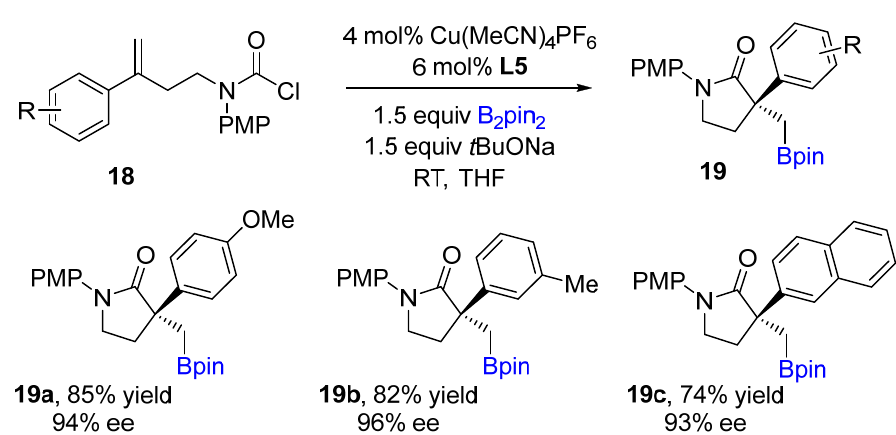
Scheme 11. Copper-catalyzed intramolecular borylative cyclization for the synthesis of polyfunc- tionalized γ